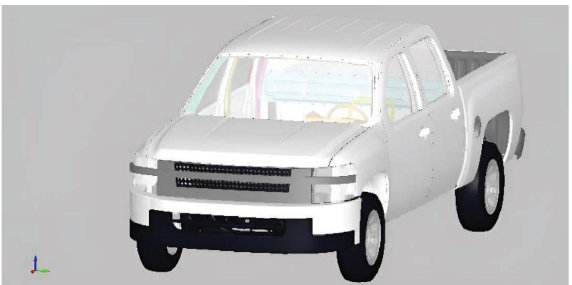
Figure 5: A 3D model of BPV.